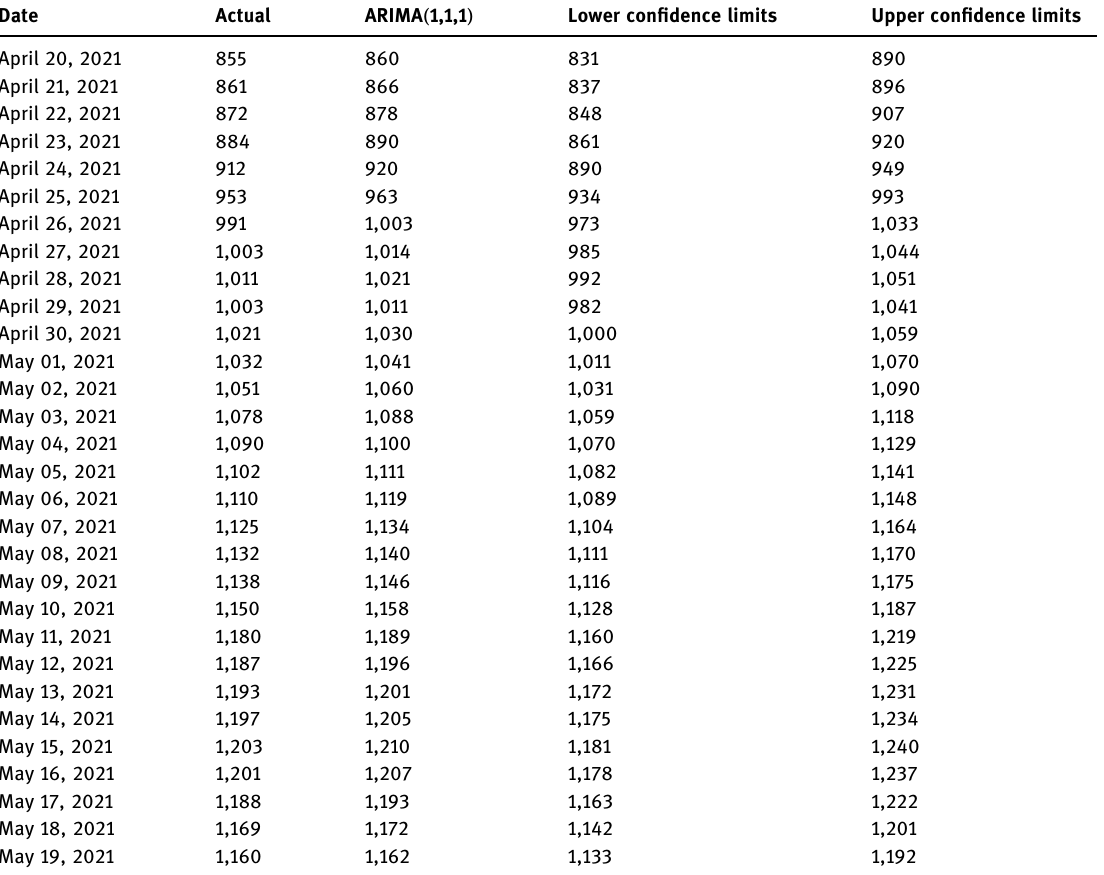
Table 3: Comparison between the actual and ARIMA ( 1,1,1 ) values with 95% con fi dence